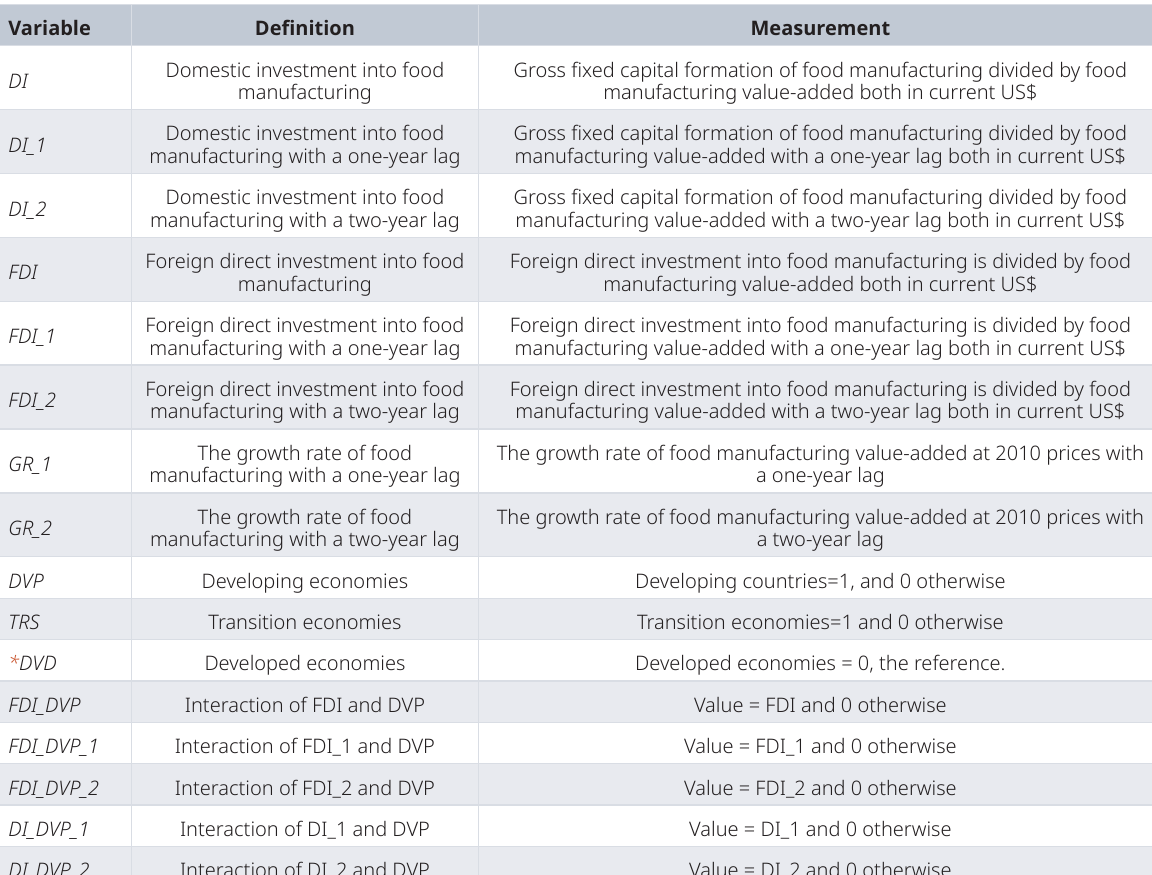
Table 2. Variable